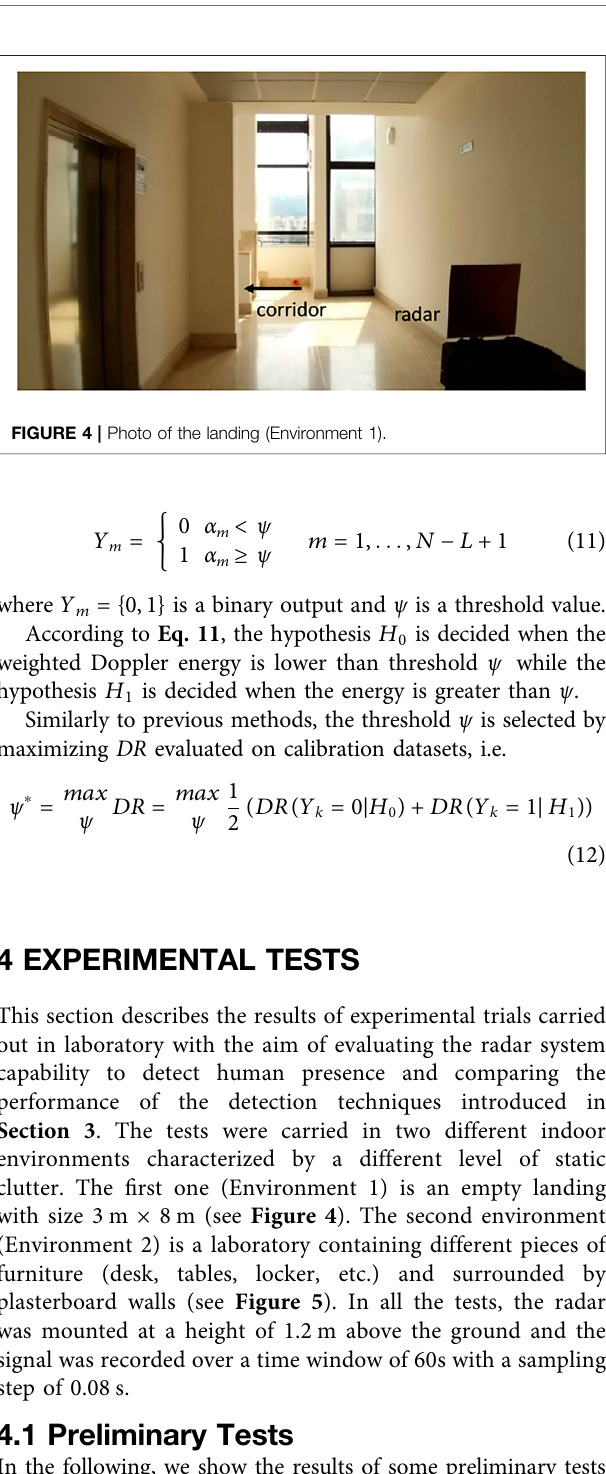
FIGURE 5 | Photo of the laboratory (Environment